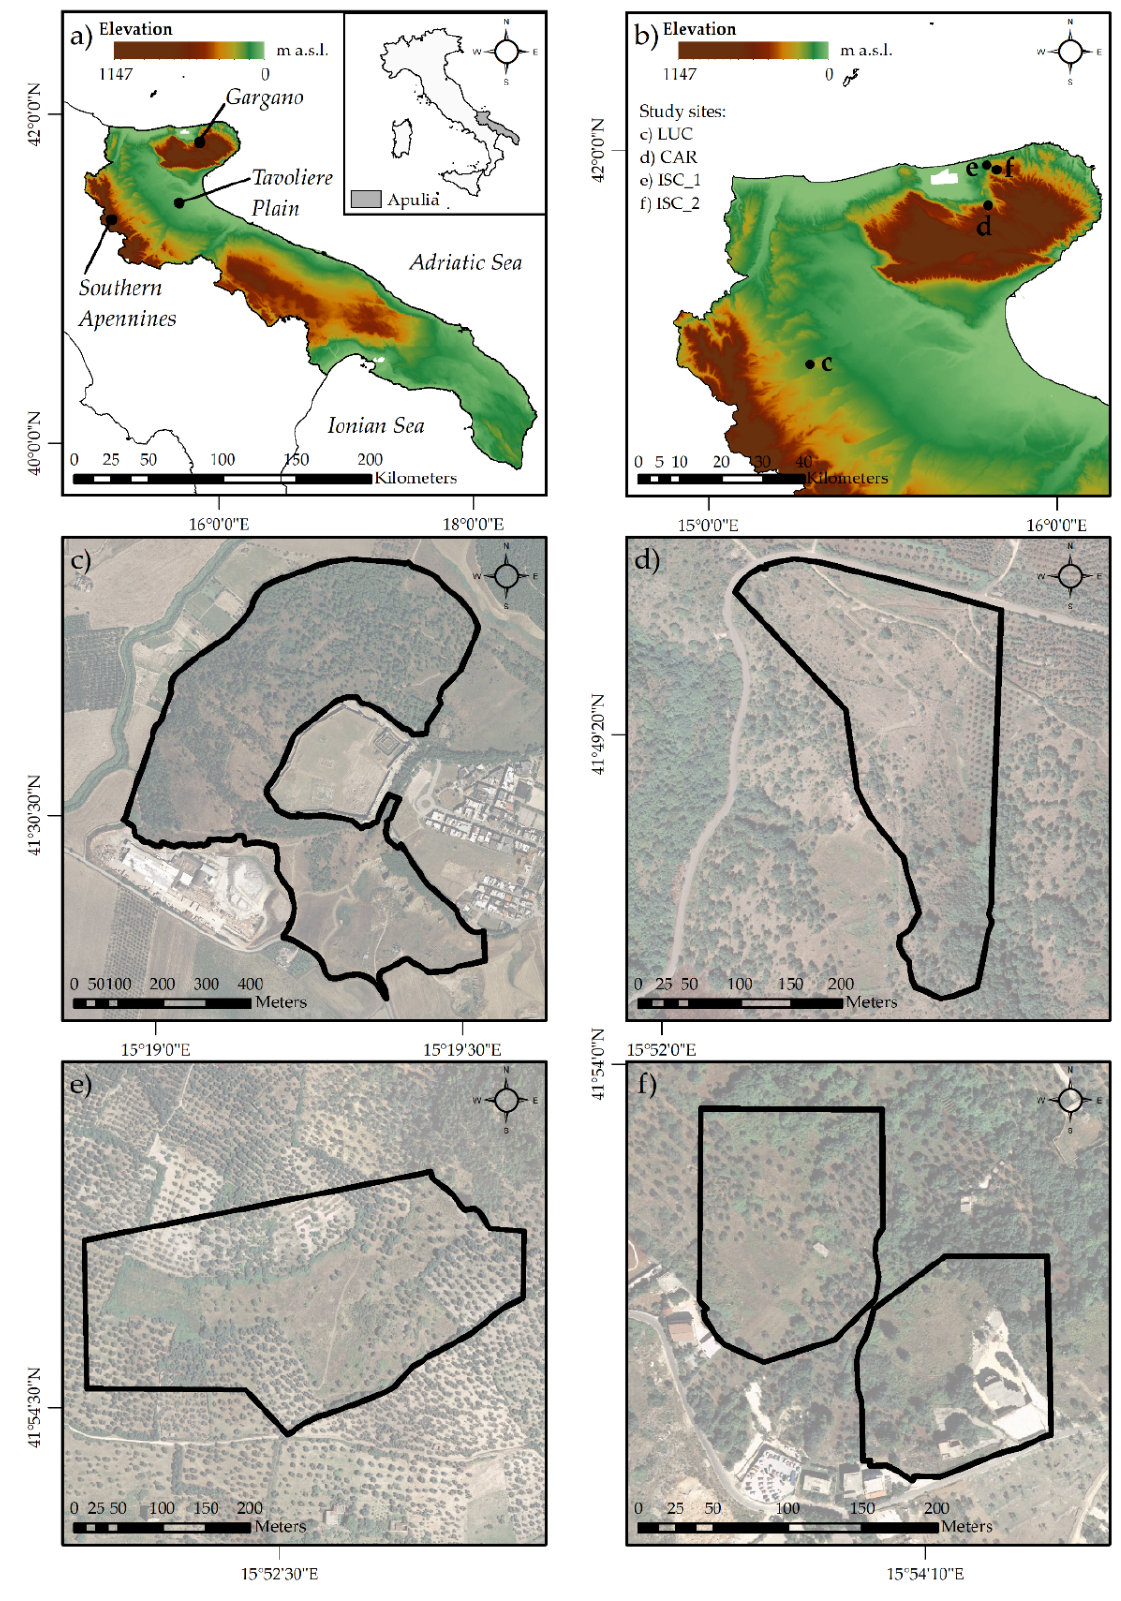
Figure 1. Geographical framework: ( a ) Apulia region and geographical areas of interest; ( b ) study site location; ( c ) LUC, Lucera site; ( d ) CAR, Carpino site; ( e , f ) ISC_1 and ISC_2, Ischitella sites.